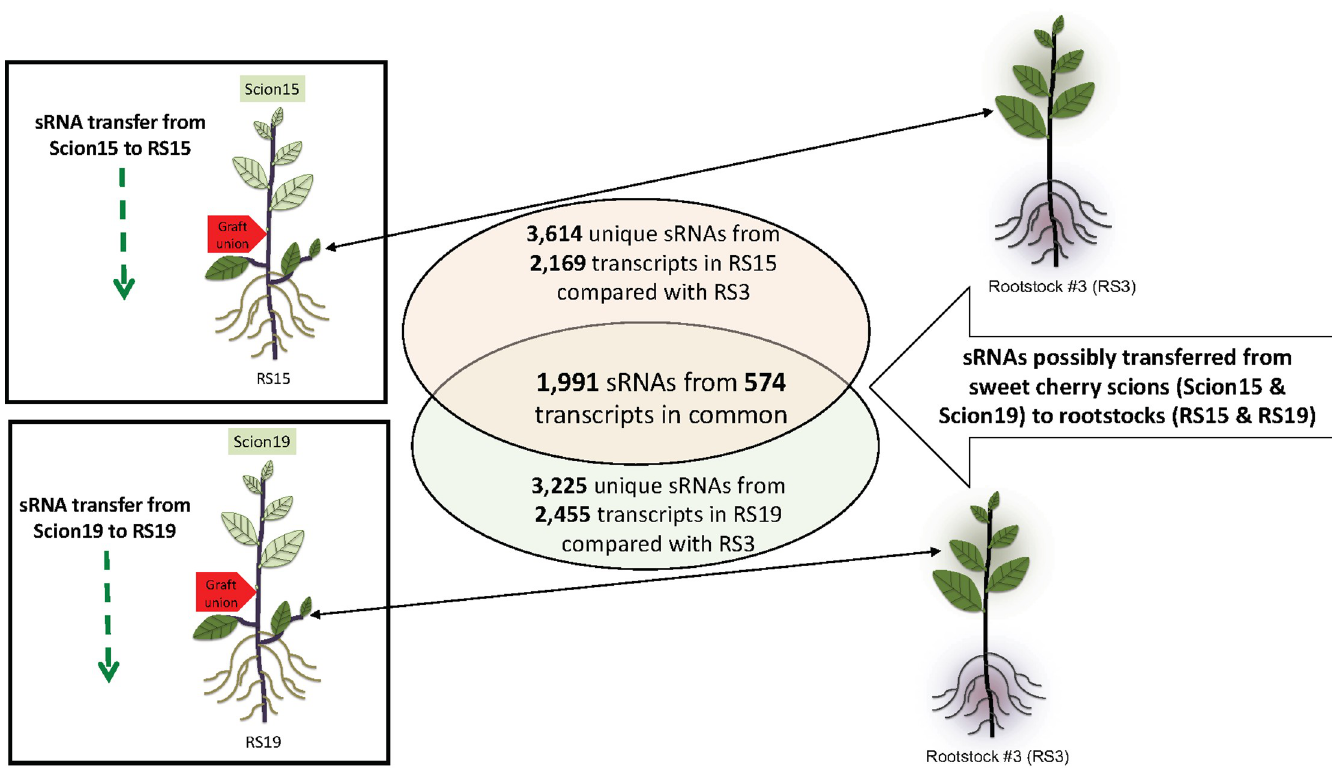
Fig 3. A diagram showing the pipeline of determining scion-to-rootstock transferred sRNAs.